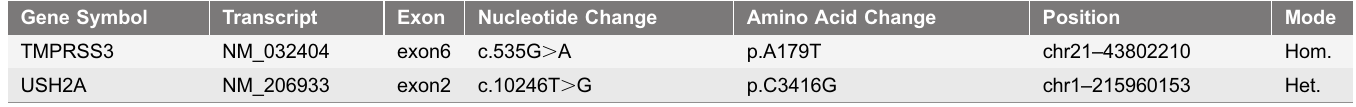
Table 1. Candidate SNPs identified in the proband with BSNHL.